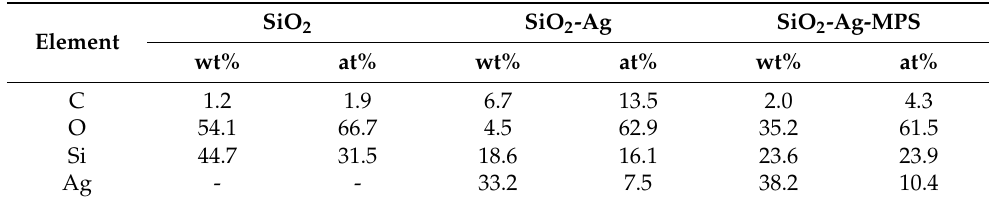
Table 3. Means of mass percent (wt%) and atomic percent (at%) values of SiO 2 , SiO 2 -Ag, and SiO 2 -Ag-MPS nanoparticles by SEM-EDX analysis.